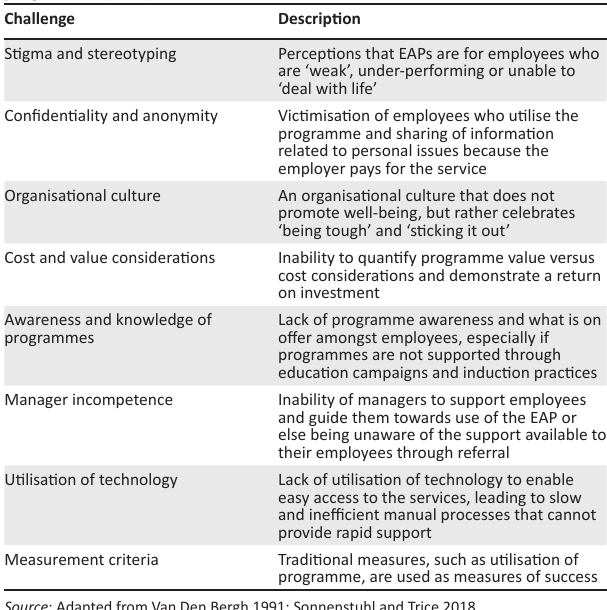
TABLE 2: Challenges encountered in implementing employee assistance programmes